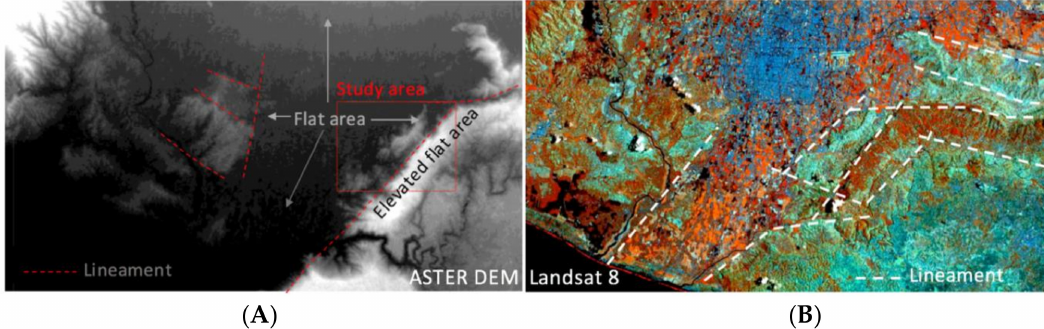
Figure 12. Lineament identification, ( A ) Lineament interpretation based on ASTER DEM; ( B ) Lineament interpretation based on the Landsat 8.